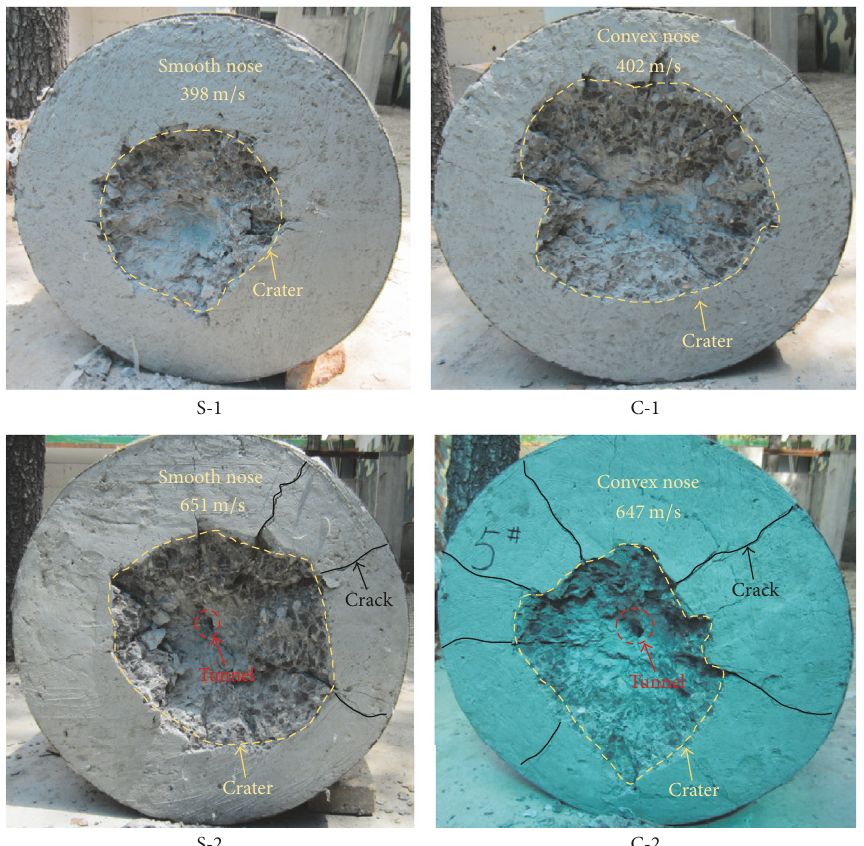
Figure 19: Damage of the concrete targets with different impact